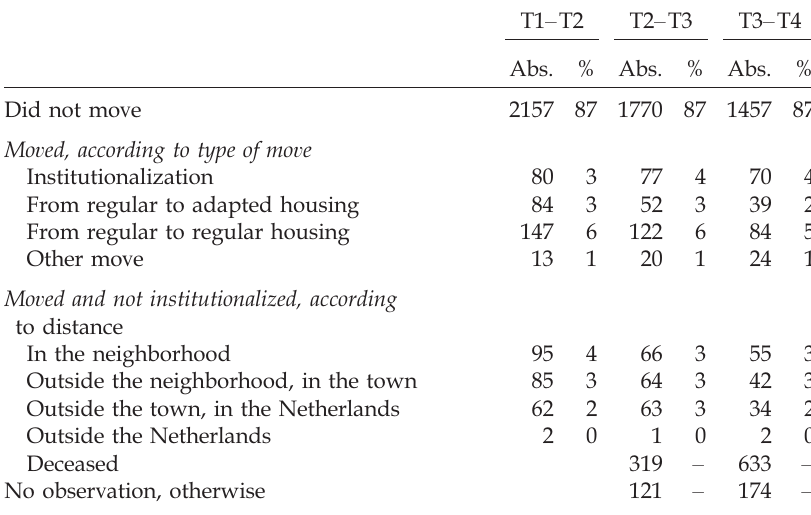
Table 1. Number of older adults who mo v ed ( n (cid:2) 2481)